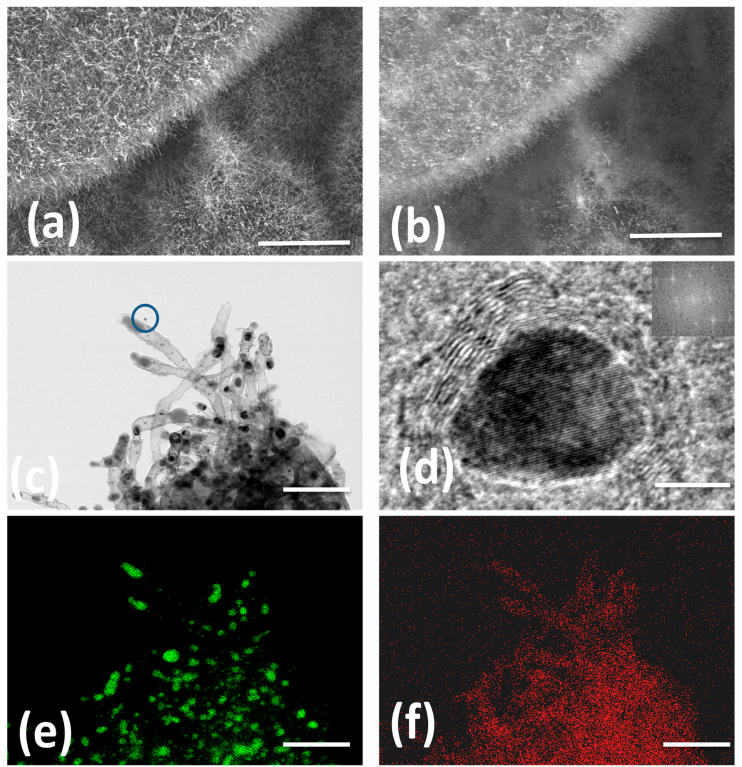
Figure 1. In-lens and secondary ion emission SEM micrographs of wPET derived short carbon nanotubes well distributed along the graphene substrate ( a , b ) HRTEM ( c ) at low and high magnification; Figures e , f are iron and nitrogen EDX maps. Scale bars are 3 µ m, 3 µ m, 300 nm, 10 nm, 300 nm and 300 nm in ( a – f ) respectively.